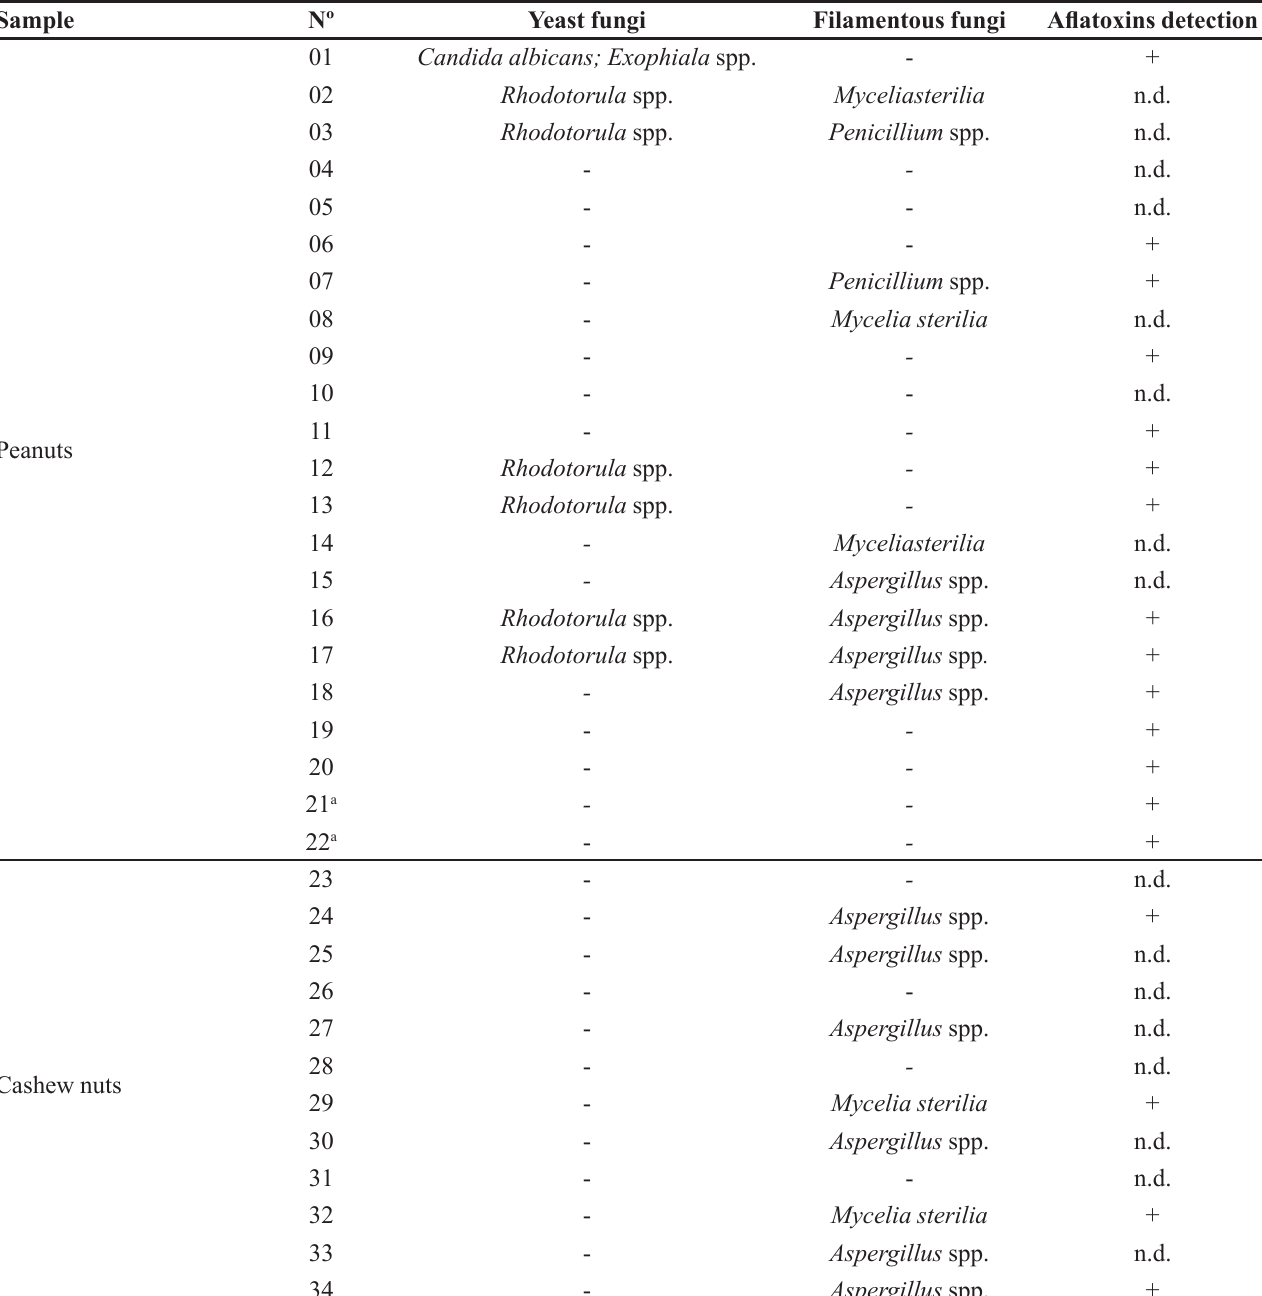
TABLE I - Occurrence of fungi and aflatoxins in peanut and cashew samples marketed in Northeast Brazil (Natal, RN, Brazil) monitored by TLC